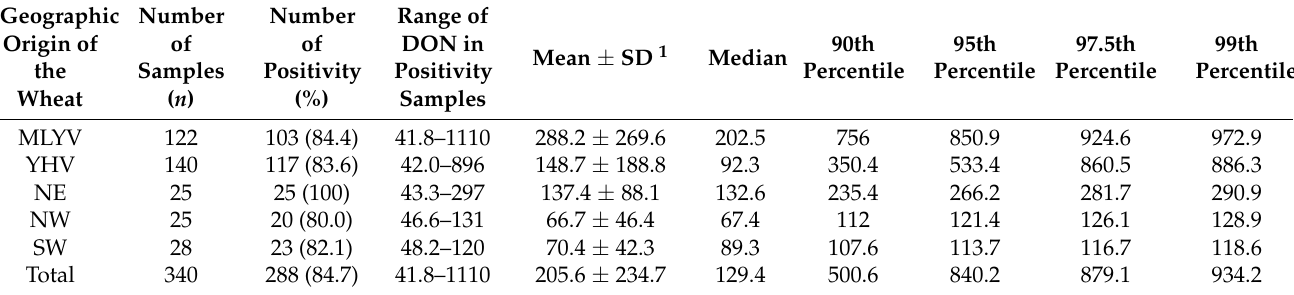
Table 2. DON contamination level in wheat-based products in Shanghai ( µ